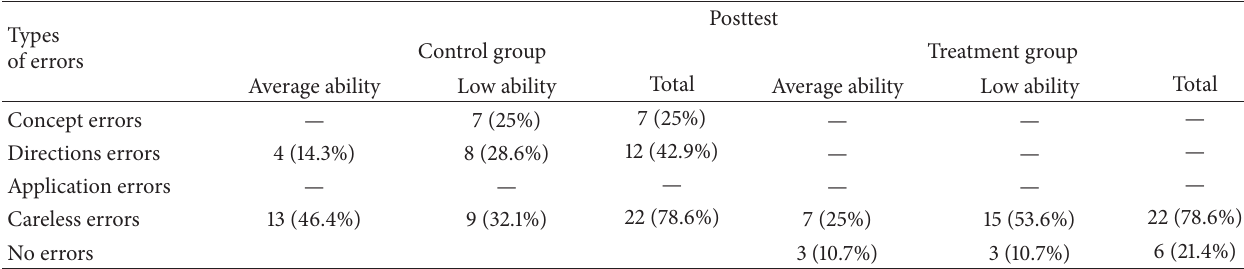
Table 6: Distribution of errors in the subtraction of fractions made by the control group and treatment group in the